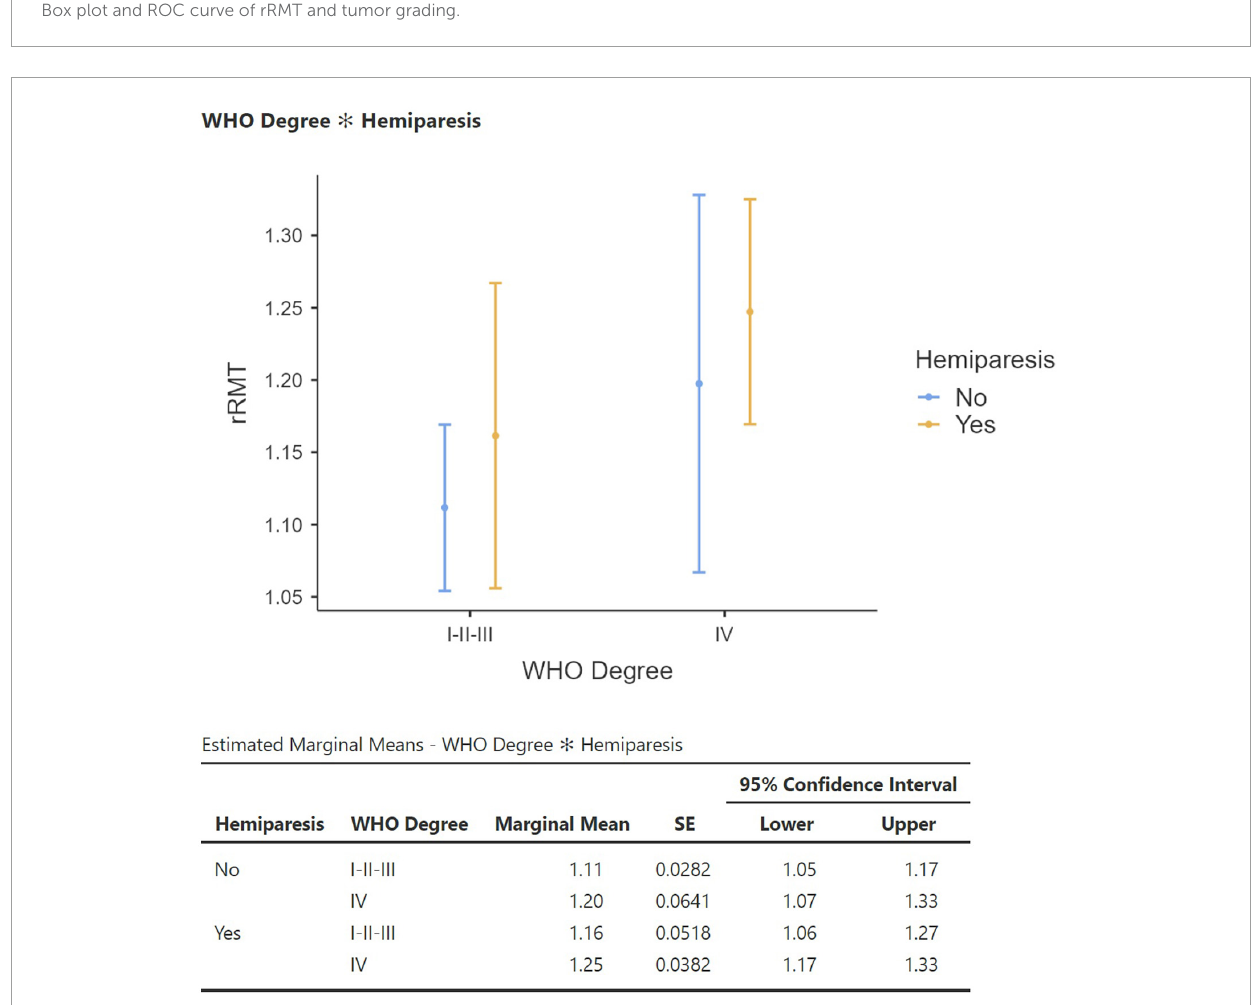
FIGURE6 Estimated marginal means graph of linear regression of rRMT, tumor grading, and hemiparesis.